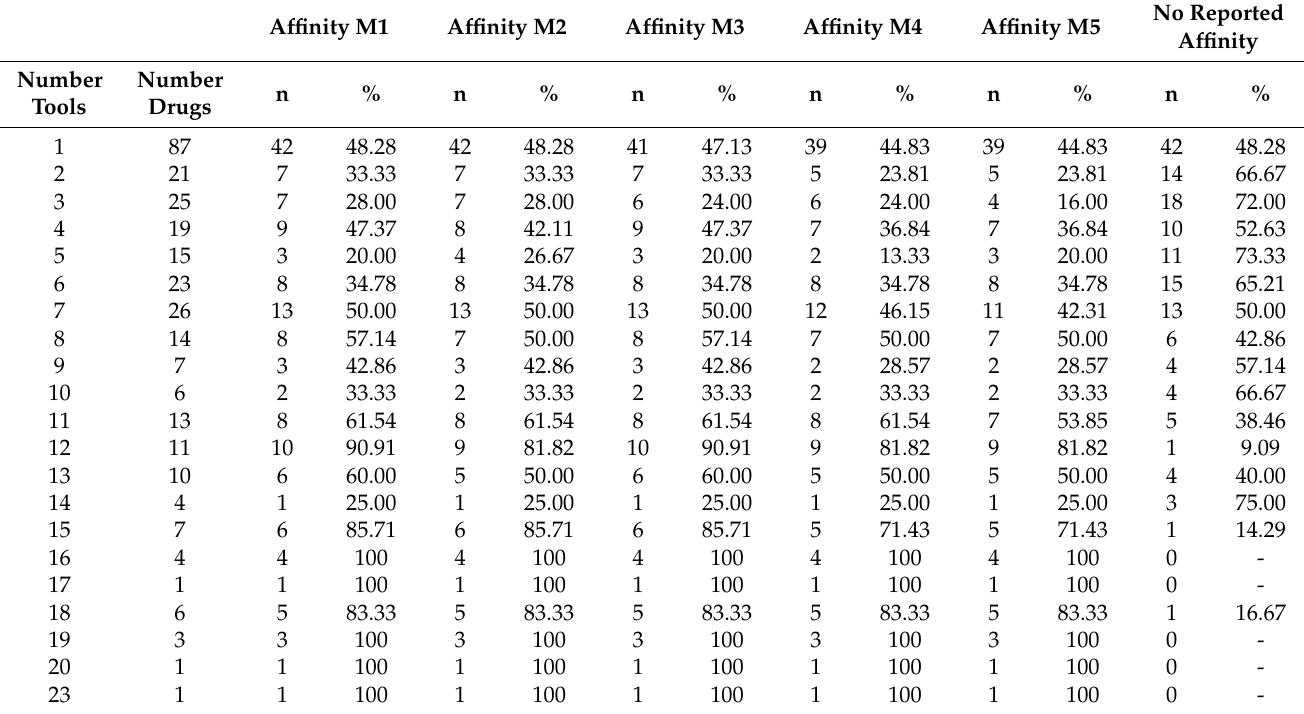
Table 2. Number of drugs with reported affinity for muscarinic receptors and their relationship with the number of anticholinergic burden tools in which they are